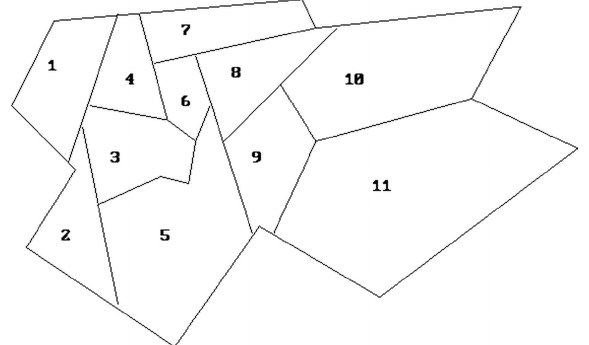
Figure 1. An example of SCP.